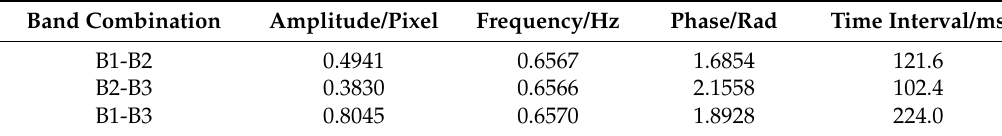
Table 4. Fitting residuals of relative registration error curves of different band combinations.